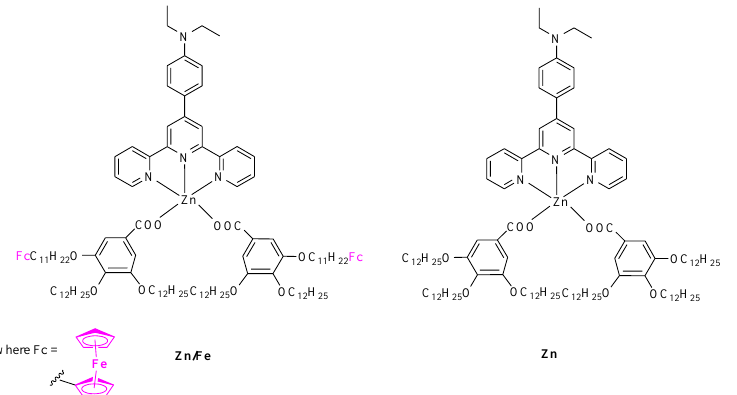
Figure 1. Molecular structure of complex Zn/Fe and the structurally analogous complex of Zn previously reported to lack ferrocene [3].